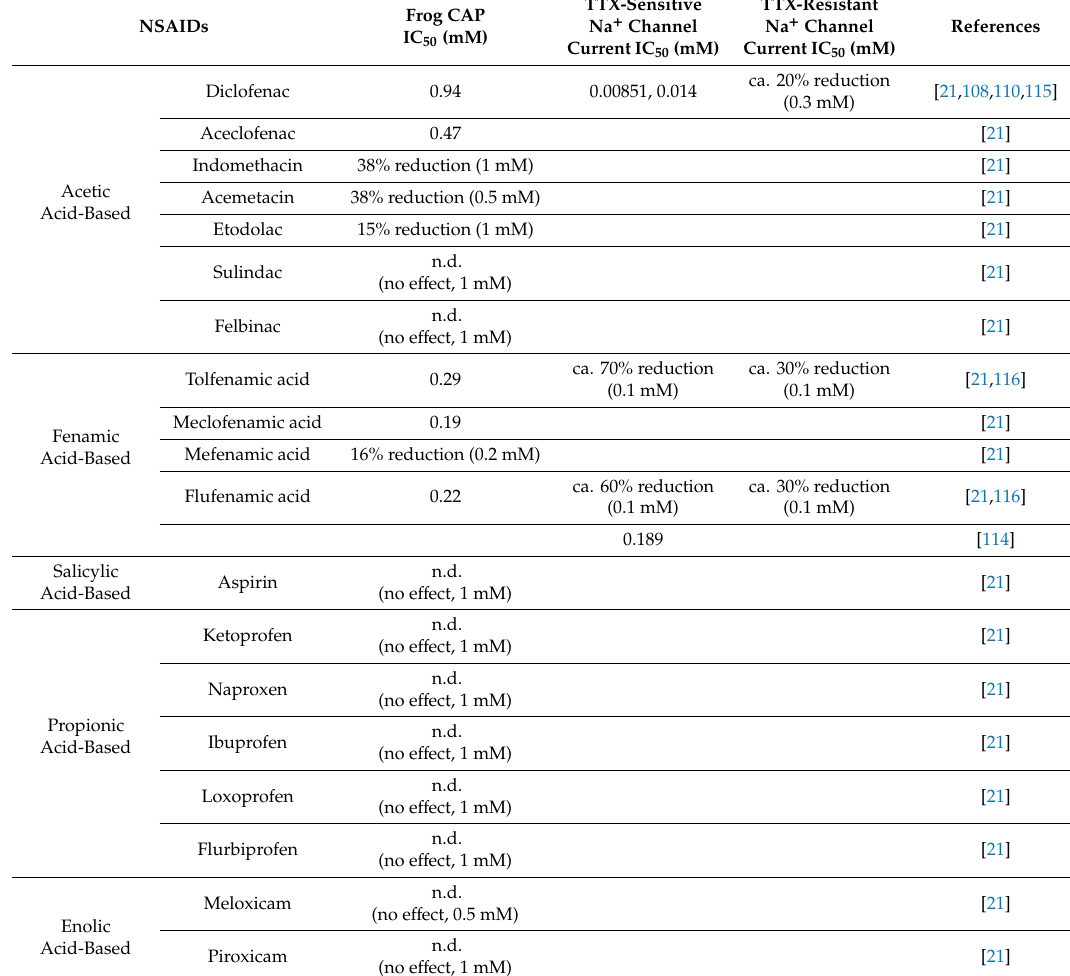
Table 2. Comparison of IC 50 values in inhibiting frog sciatic nerve fast-conducting CAPs, TTX-sensitive or -resistant Na + channels among